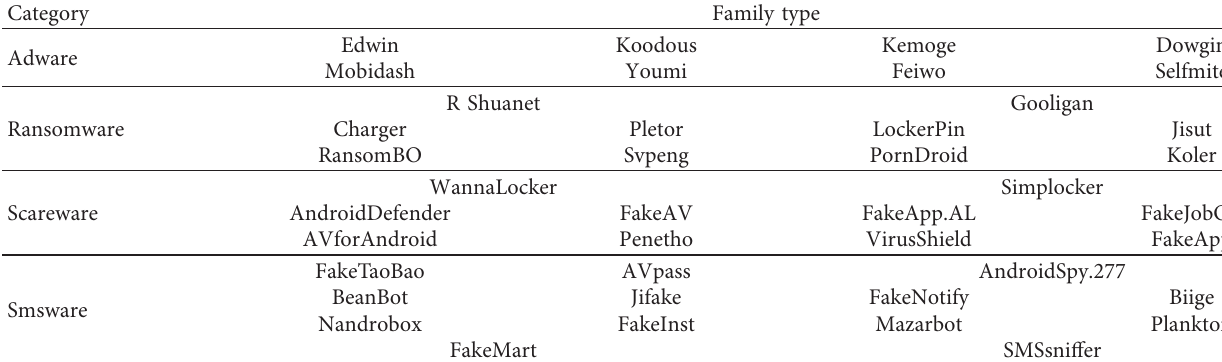
Table 1: Category and family of